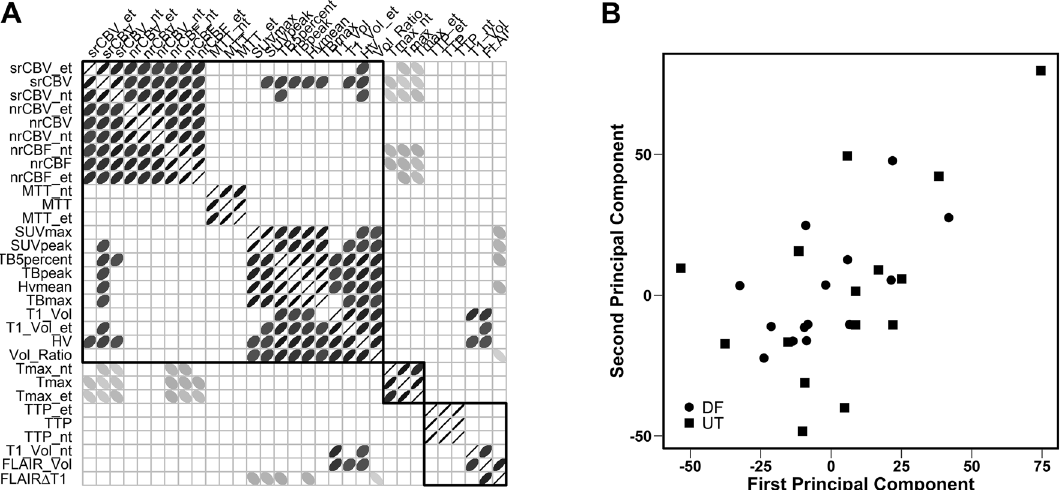
Figure 2. (A) Spearman correlations between all imaging parameters. Significant correlations (p ≤ 0.05) are indicated with ellipses with the shape of each ellipse reflecting the direction and strength of the correlation. Positive correlations are described with ellipses directed from the lower left to the upper right and negative correlations are described with ellipses directed from the upper left to the lower right. Strong correlations are described with thin ellipses and weak correlations with thick ellipses. Non-significant correlations are indicted with blanks. ( B) Scatter plot of the first and second principal components by clinic based all imaging parameters in n = 33 subjects; the centroids were not significantly different (p =